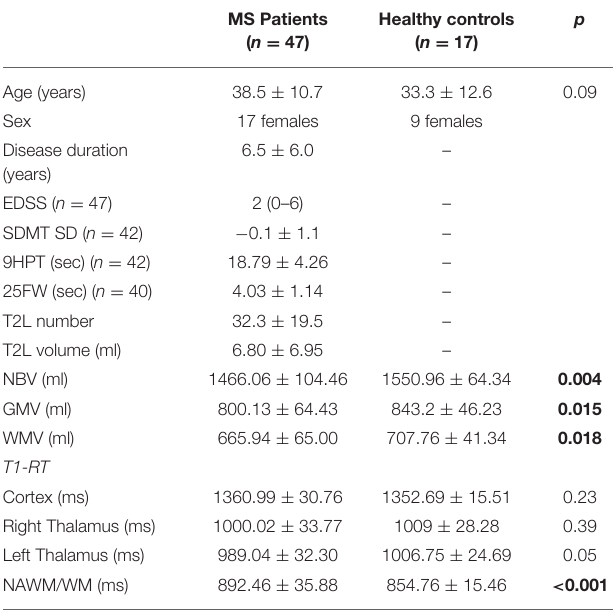
TABLE 1 | Demographic, clinical, and conventional MRI data obtained from patients with MS and healthy